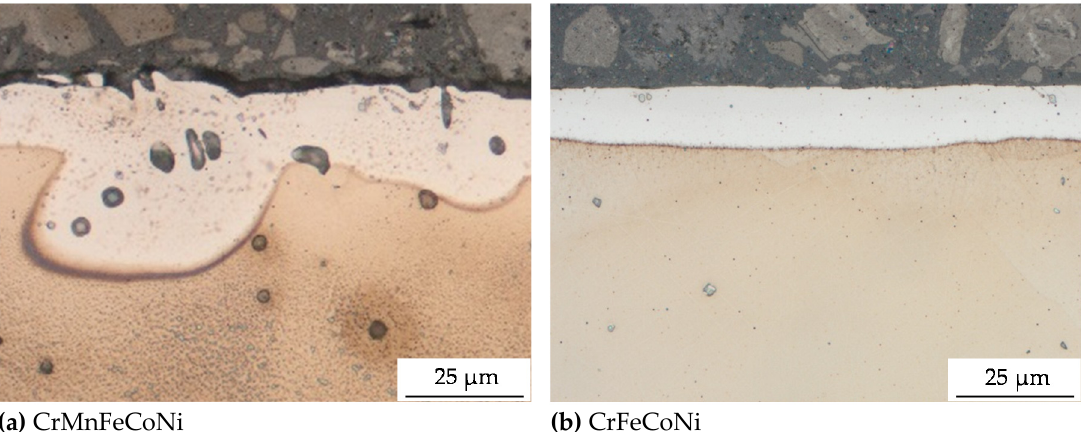
Figure 2. Light microscopy images of nitrocarburised CrMnFeCoNi and CrFeCoNi high-entropy alloys (HEAs) in cross-section view of the surface layer using Beraha-II colour etchant.